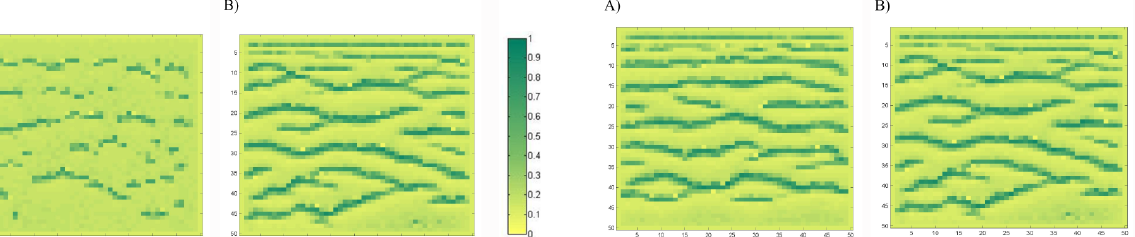
Fig. 19. Effect of local plants’ interactions on pattern formation. (A) No interactions. (B) Spatially variable (function of neighbors’ vegetation and surface runoff) interactions.